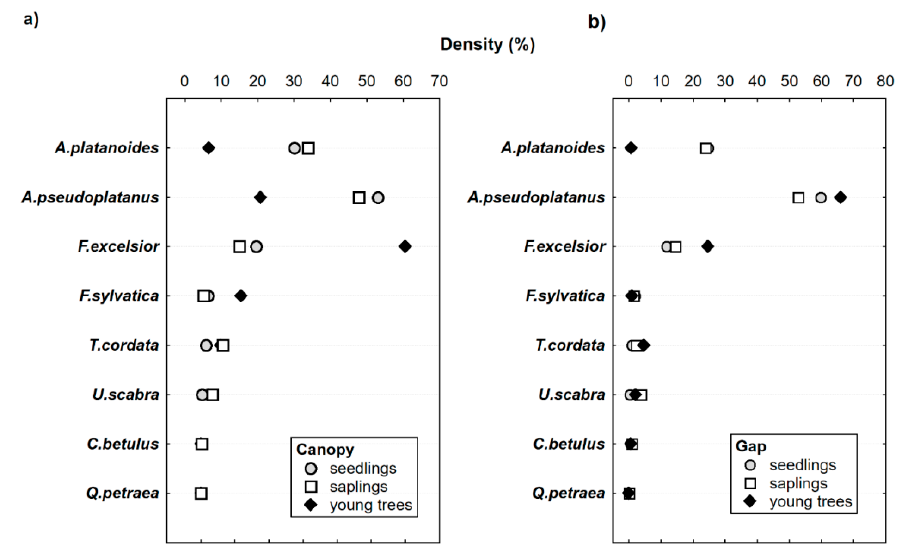
Figure 5. Relative density of seedlings, saplings and young trees under ( a ) closed canopy and ( b ) in expanded gaps.